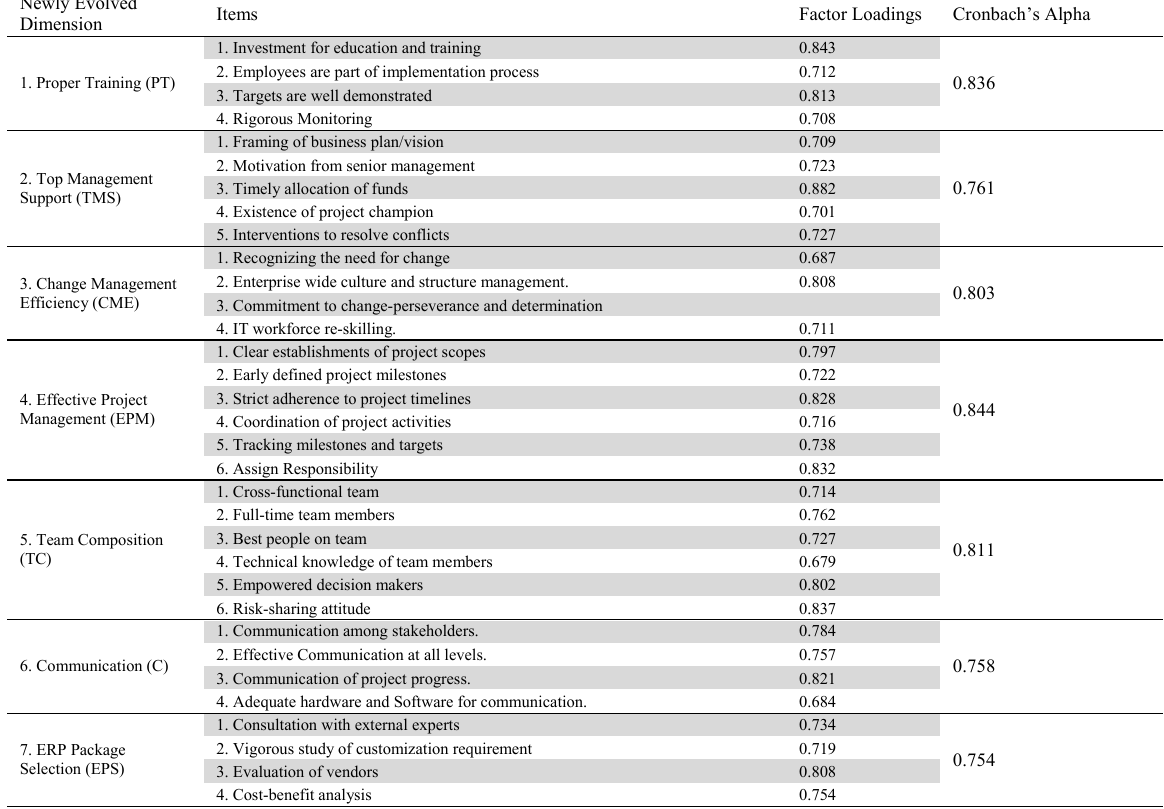
Factor Loadings and Reliability scores Newly Evolved Dimension